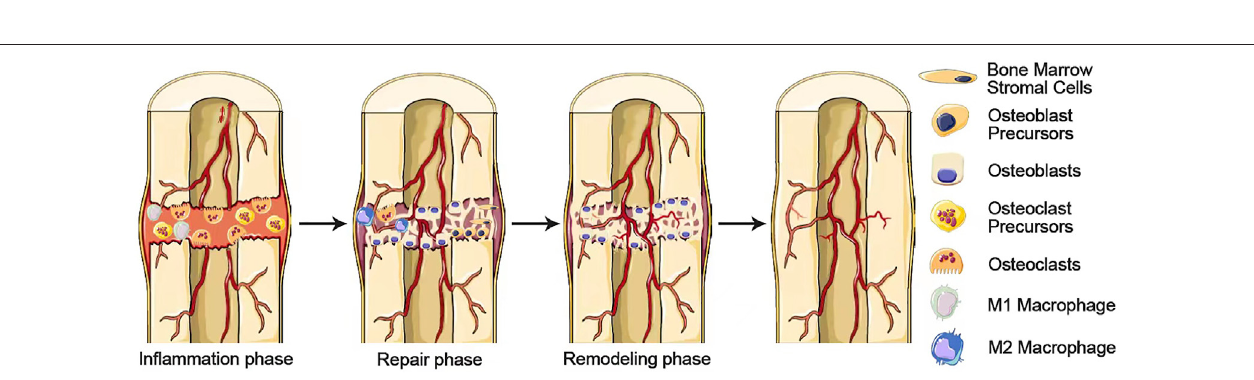
FIGURE 4 | A complex and well-orchestrated bone repair process involving three phases. In fl ammation, repair, and remodeling phases.